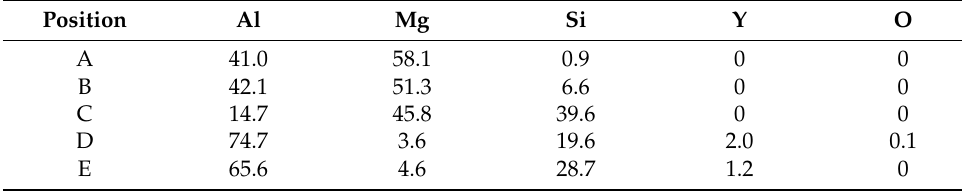
Figure 4. SEM microstructures of laser cladded coatings in this study: ( a ) AS, ( b ) AS1Y, ( c ) AS1.5Y, ( d ) AS2Y, ( e ) AS under magnification (Positions A, B and C are the EDS analysis area), and ( f ) AS2Y under magnification (Positions D and E are the EDS analysis area). Table 3. Chemical compositions of the microstructure analyzed by SEM-EDS